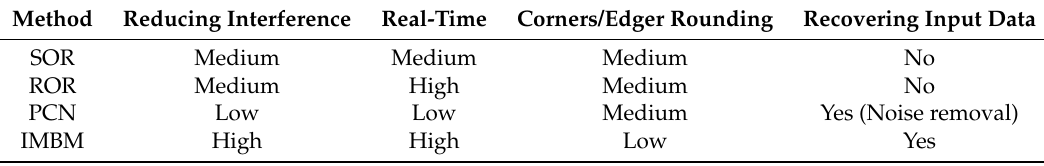
Table 6. Functionality of compared